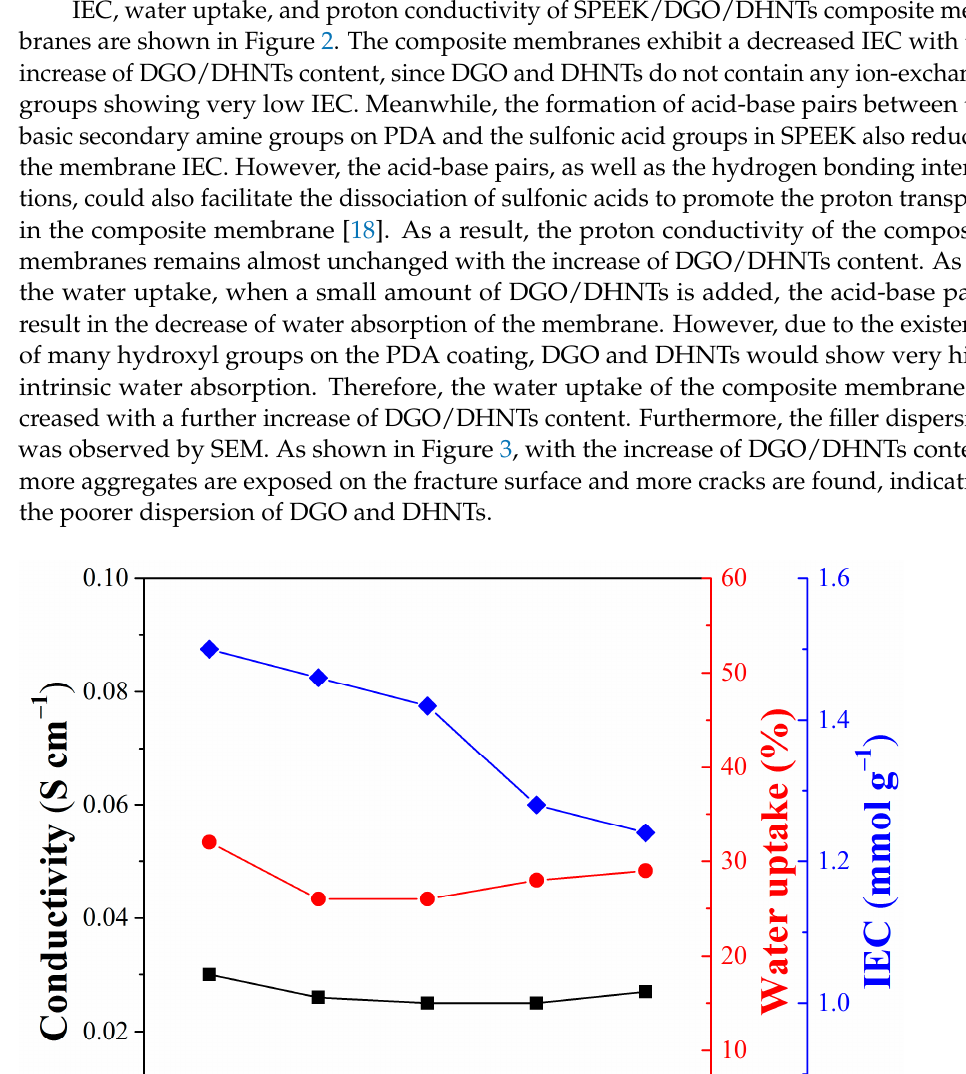
Figure 3. SEM images of SPEEK/DGO/DHNTs composite membranes with DGO/DHNTs (1:1) con- tent of ( a ) 5 wt%, ( b ) 10 wt%, ( c ) 15 wt%, and ( d ) 20 wt%. 3.3. Performance of SPEEK/DGO/DHNTs/HPW Composite Membranes In this work, we aimed to anchor HPW by DGO/DHNTs, while the poor dispersion would harm the anchoring efficiency. Moreover, the optimal performance is achieved for the